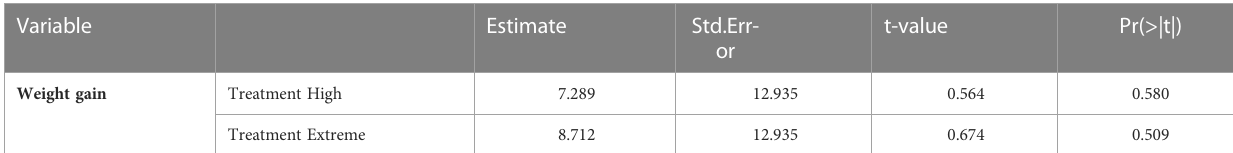
TABLE 3 Statistical results of the Generalized Linear on weight gain (%) of long-snouted seahorse exposed to three temperature treatments – control (17°C), high (20°C), and extreme (24°C). Variable